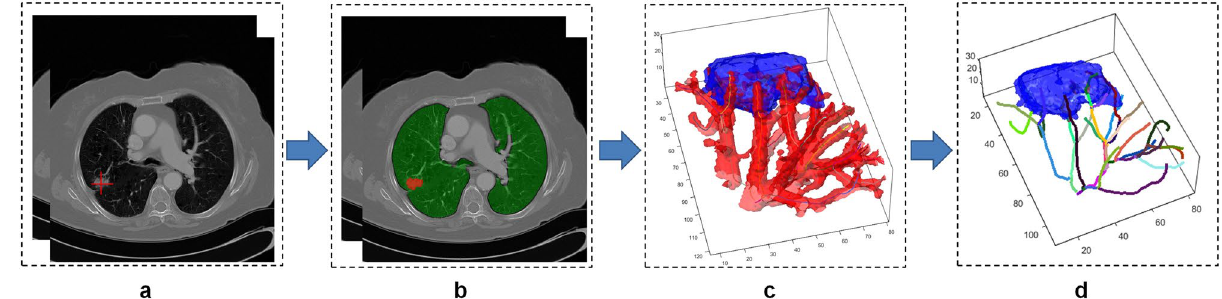
3D volume via a region growing algorithm 57 . ( d ) The center lines and branches of the vasculature are detected lines of the vessels.